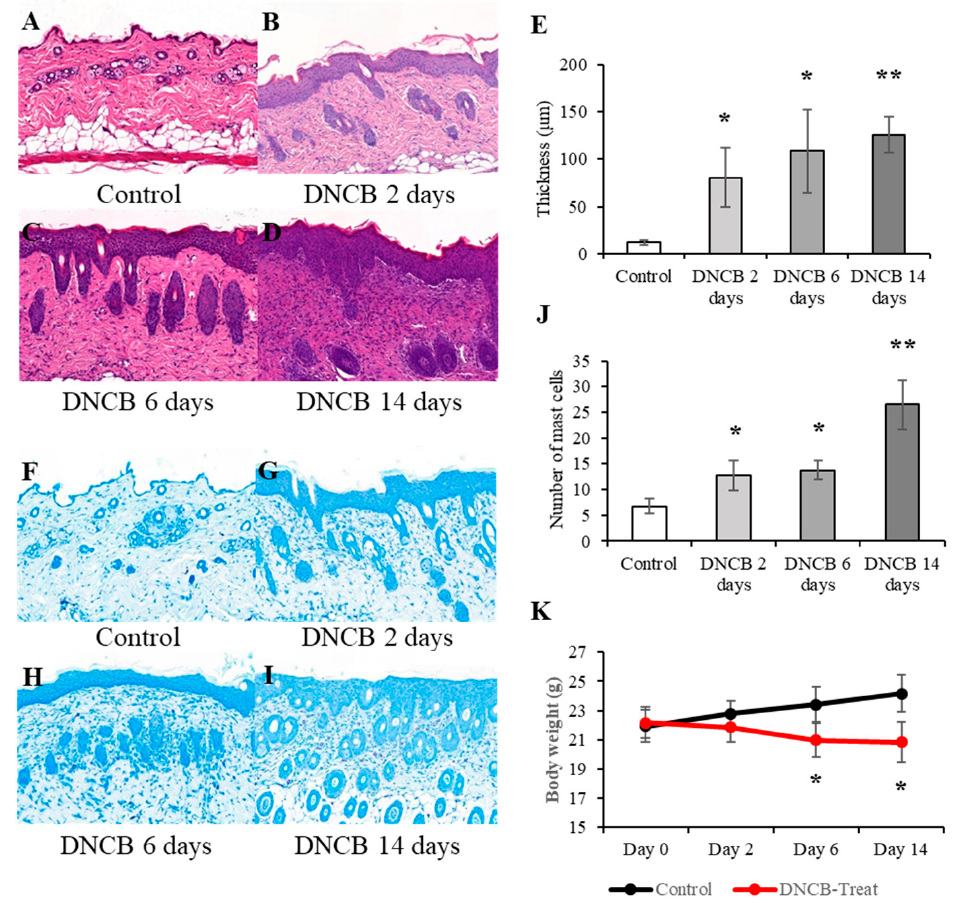
Figure 2. Atopic dermatitis (AD)-like lesions and body weight loss were induced by 2,4-dinitrochlorobenzene. Hematoxylin and eosin staining showed an increase in the stratum corneum and the epidermal thickness, which are typical AD lesions; ( A ) control, ( B ) DNCB 2 days, ( C ) DNCB 6 days, and ( D ) DNCB 14 days. ( E ) Quantification of changes in the thickness of the epidermis. The data are expressed as the mean ± SD; * = p < 0.05, ** = p < 0.001. Toluidine blue staining was performed to identify mast cell infiltration of the dermis; ( F ) control, ( G ) DNCB 2 days, ( H ) DNCB 6 days, and ( I ) DNCB 14 days. ( J ) Quantification of mast cells infiltrating into the dermal layer. The data are expressed as the mean ± SD; * = p < 0.05, ** = p < 0.001. ( K ) The change in body weight during DNCD-treatment is shown. The data are expressed as the mean ± SD; * = p < 0.05, n = 5 per group.